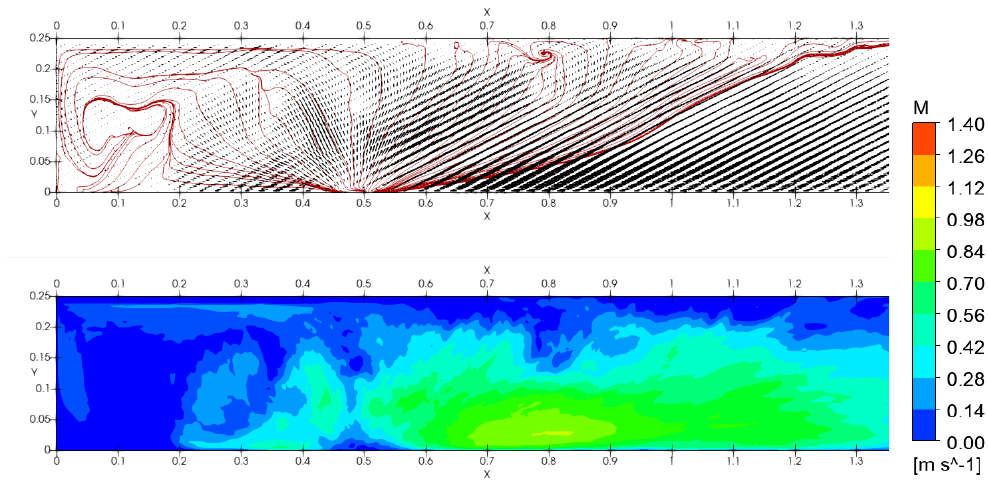
Figure 20. LBM, vector lines ( top ) and the magnitude of time-averaged 2D velocity ( bottom ) in vertical plane ( z = − 141mm ) .